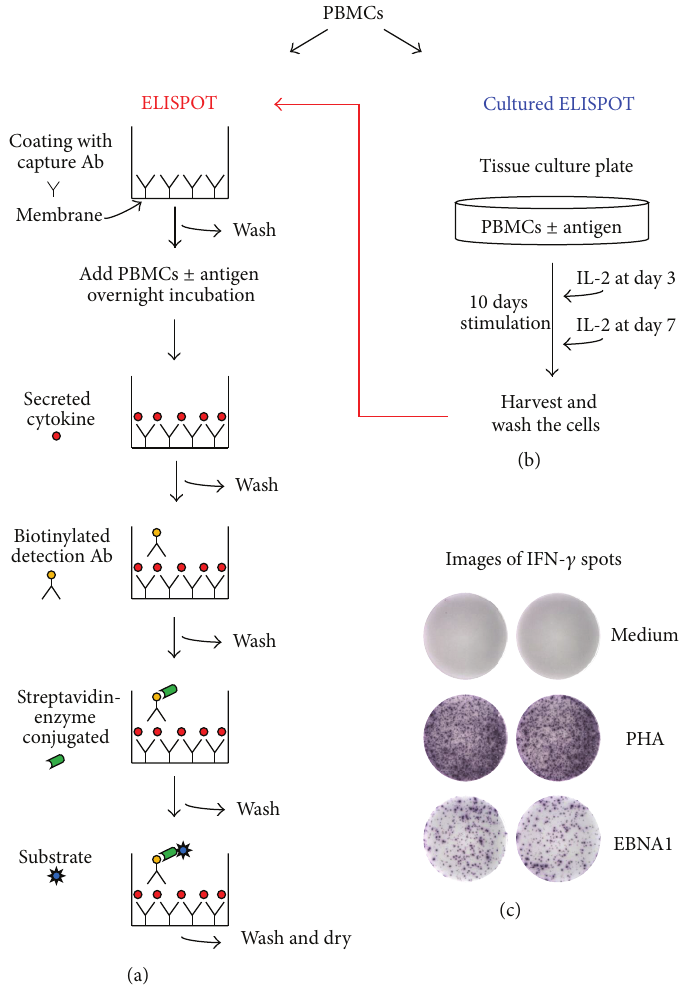
Figure 1: Schematic representation of ELISPOT assays. (a) The standard ELISPOT is used to measure antigen-specific effector T cells. The membrane’s plate is coated with an antibody (Ab) specific for the cytokine of interest (capture Ab). Peripheral blood mononuclear cells (PBMCs) are added with or without antigen and incubated overnight. The cytokine released by the cells binds to the capture Ab. After washing, an anti-cytokine biotinylated detection Ab is added followed by streptavidin conjugated with an enzyme, and finally an enzyme substrate is added which produces colored spots. (b) The cultured ELISPOT assay is used to measure antigen-specific memory T cells. PBMCs are cultured with or without antigen for 10 days, with the addition of interleukin-2 (IL-2) at days 3 and 7, allowing the expansion of antigen- specific T cells. Then, cells are restimulated with the same antigen used during the 10-day period in the ELISPOT assay. (c) Spots are counted using an automated ELISPOT reader. Representative images of interferon- 𝛾 (IFN- 𝛾 ) ELISPOT wells are shown. PBMCs from an Epstein-Barr virus (EBV) seropositive healthy subject were evaluated in response to medium alone (negative control), phytohemagglutinin (PHA, positive control) and a peptide pool (15 amino acids in length with an 11 amino acid overlap) spanning full-length EBV latent protein